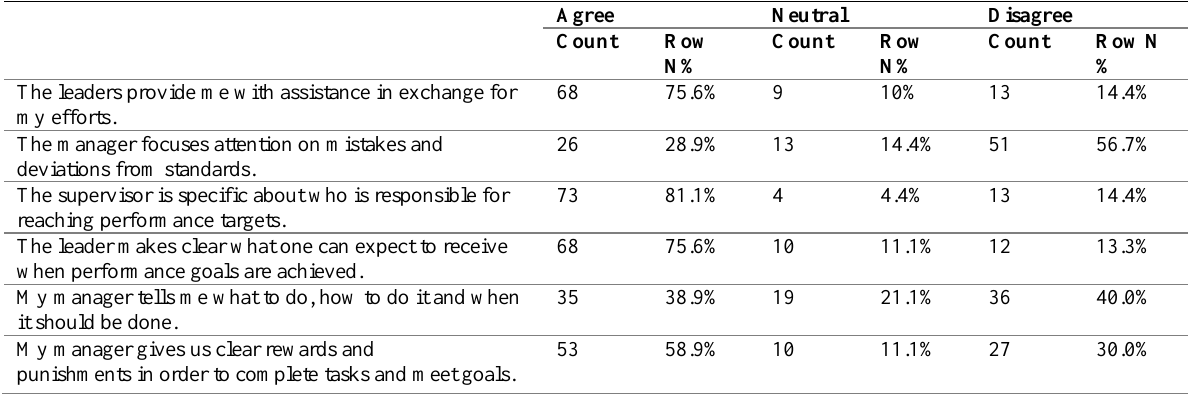
Table 3: frequency distribution of transactional leadership style responses (n=90)